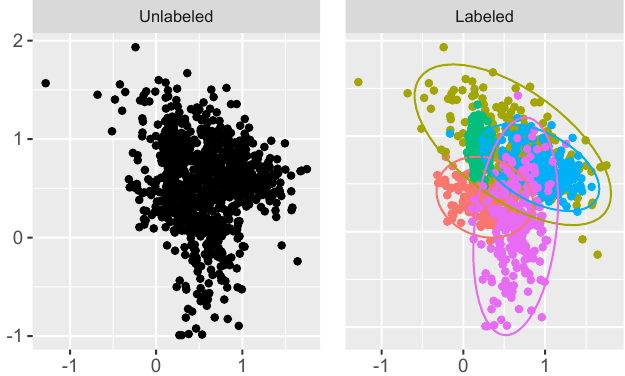
Figure 6. Simulated dataset with high overlapping clusters.